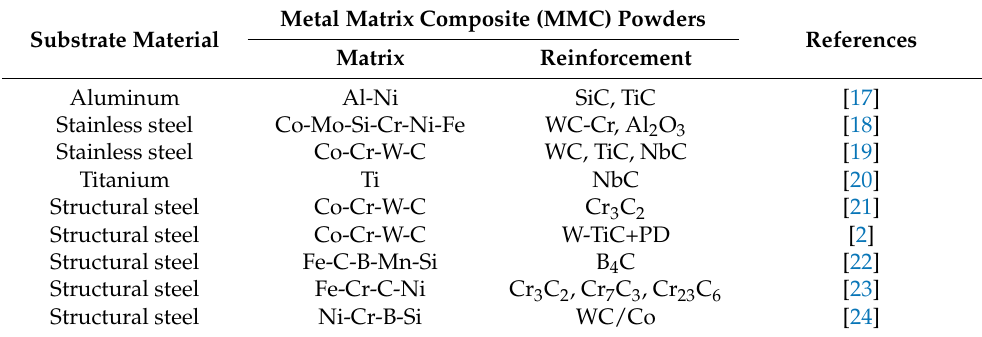
Table 1. Chemical Composition of MMC powders used in PPTAW processes for abrasive wear resistance applications, as reported from